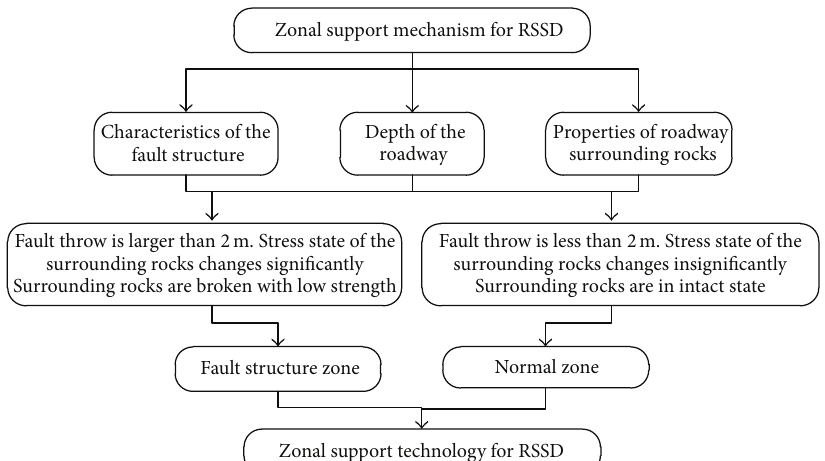
Figure 13: Zonal support mechanism for RSSD.